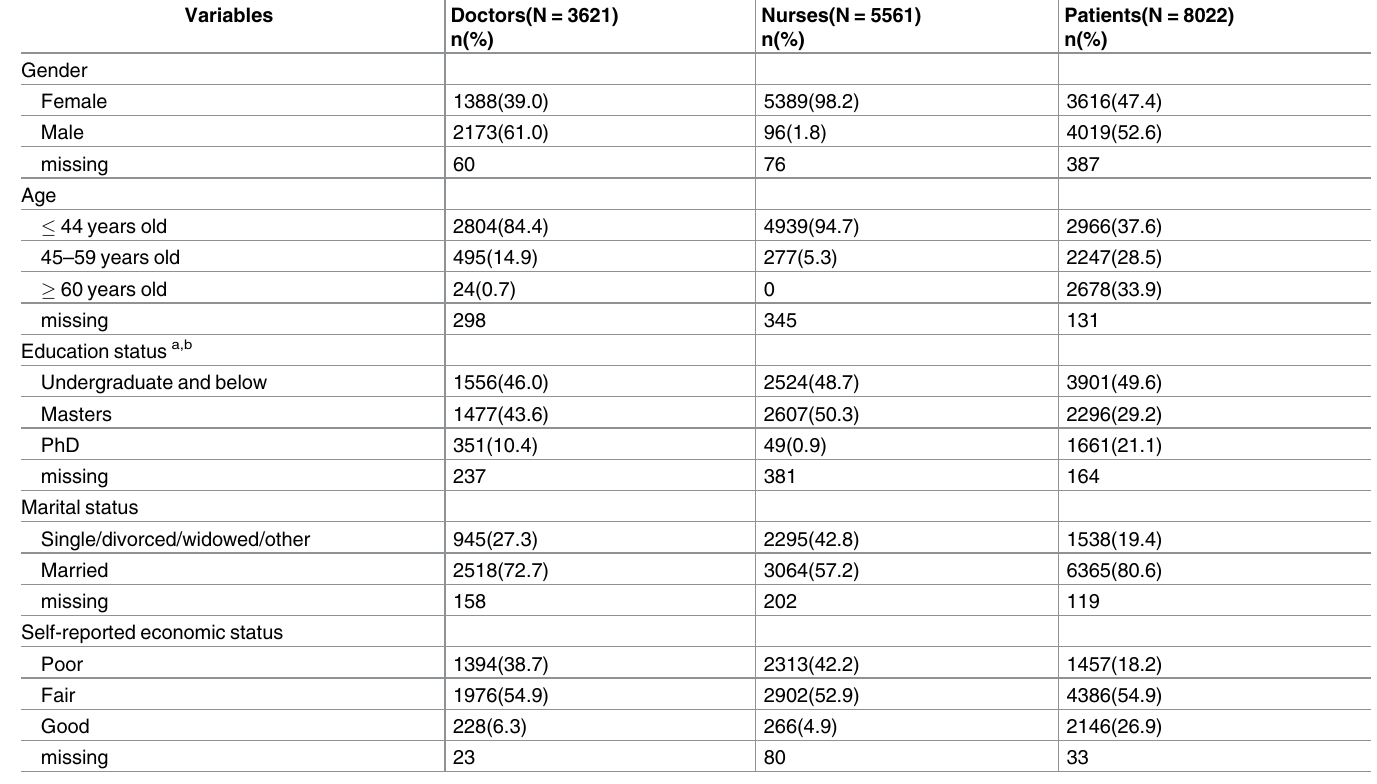
Table 1. Socio-demographic characteristic of the